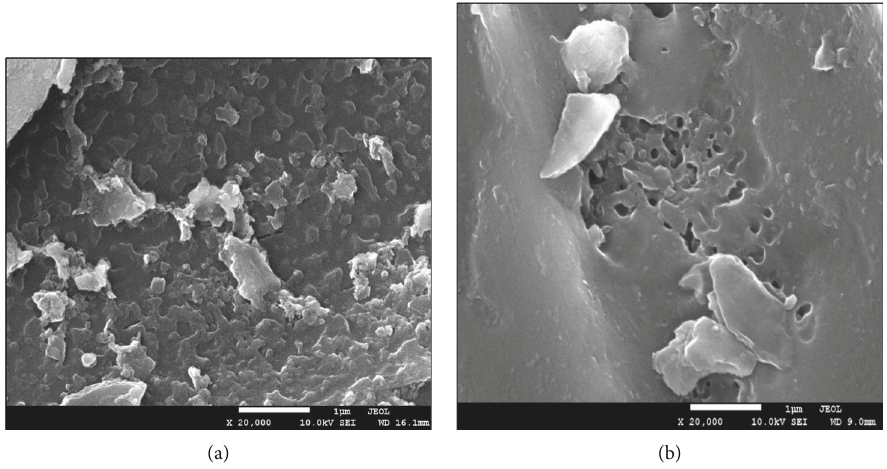
Figure 7: SEM images of BC500 (a) before and (b) after MB